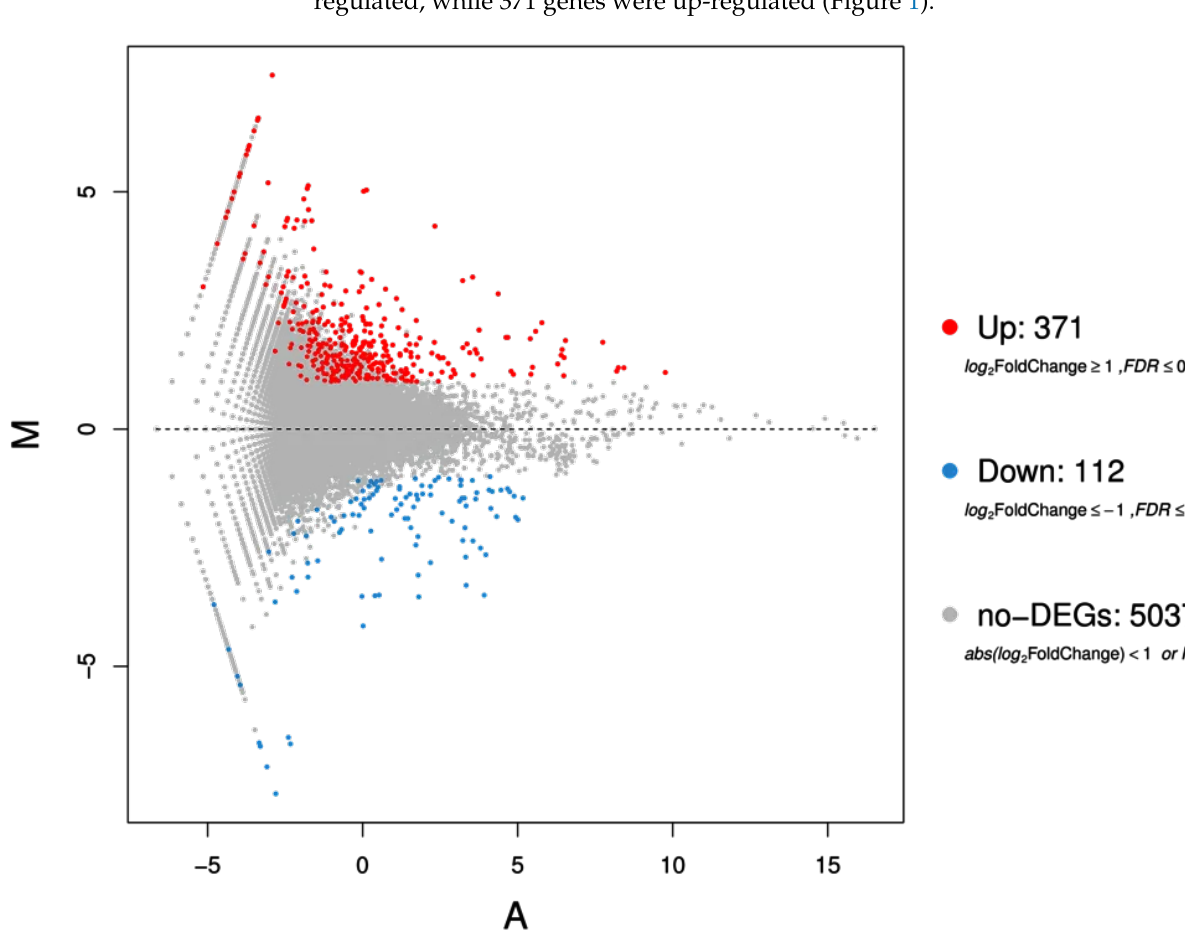
Figure 1. MA plot showing genes differentially expressed (blue and red dots) in high-B (TB 10 mM)- treated shoots of the T. dicoccum (Td) genotype PI94655 compared to 3.1 µM B (control) treatment. Y axis (M) and X axis (A) denote log2 transformed fold change and log2 transformed mean expression level, respectively.